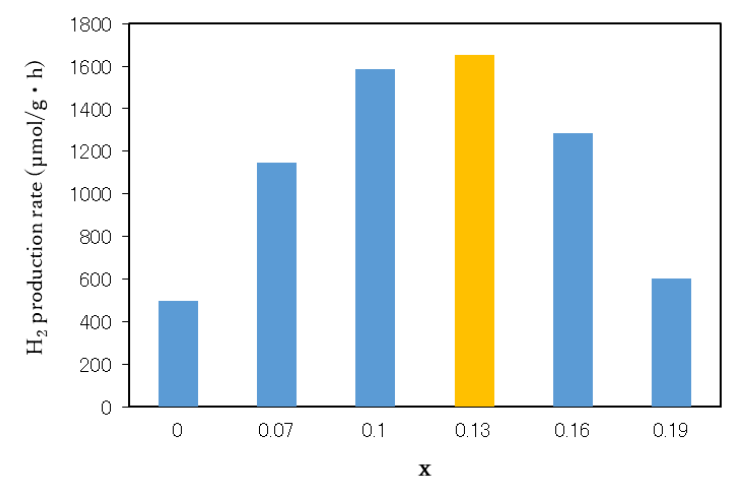
Figure 6. Photocatalytic hydrogen production rate with Zn (1 − 2x) (CuGa) x In 2 S 4 .